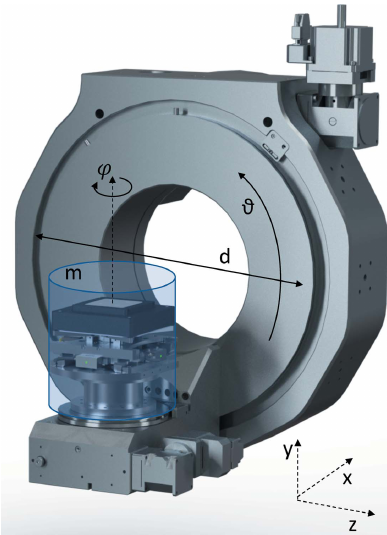
Figure 7 A 3D rendering of the two-circle goniometer assembly. The # and ’ rotations are highlighted. The transparent cylinder represents the volume envelope available for the sample scanner and sample environment. For a torque-free assembly, the total mass m should be 5